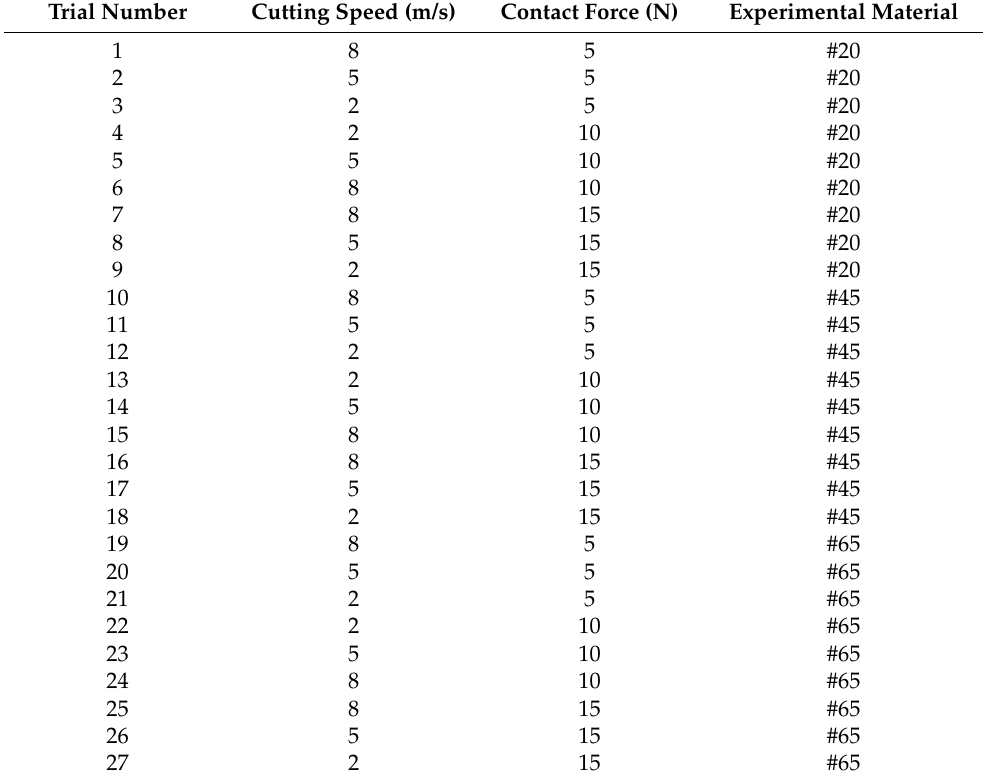
Table 1. Experimental